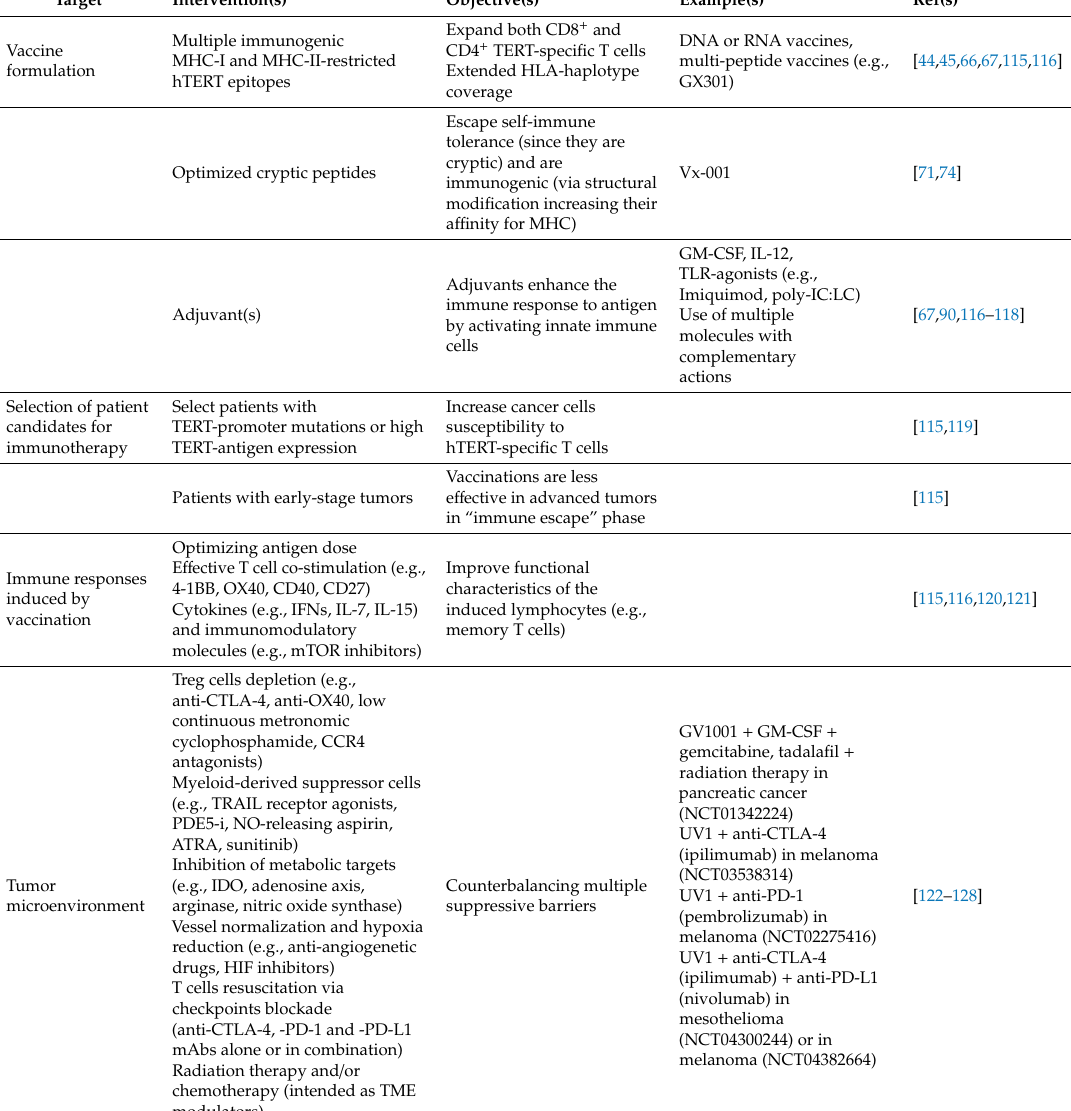
Table 2. Strategies to increase the e ffi cacy of hTERT-based